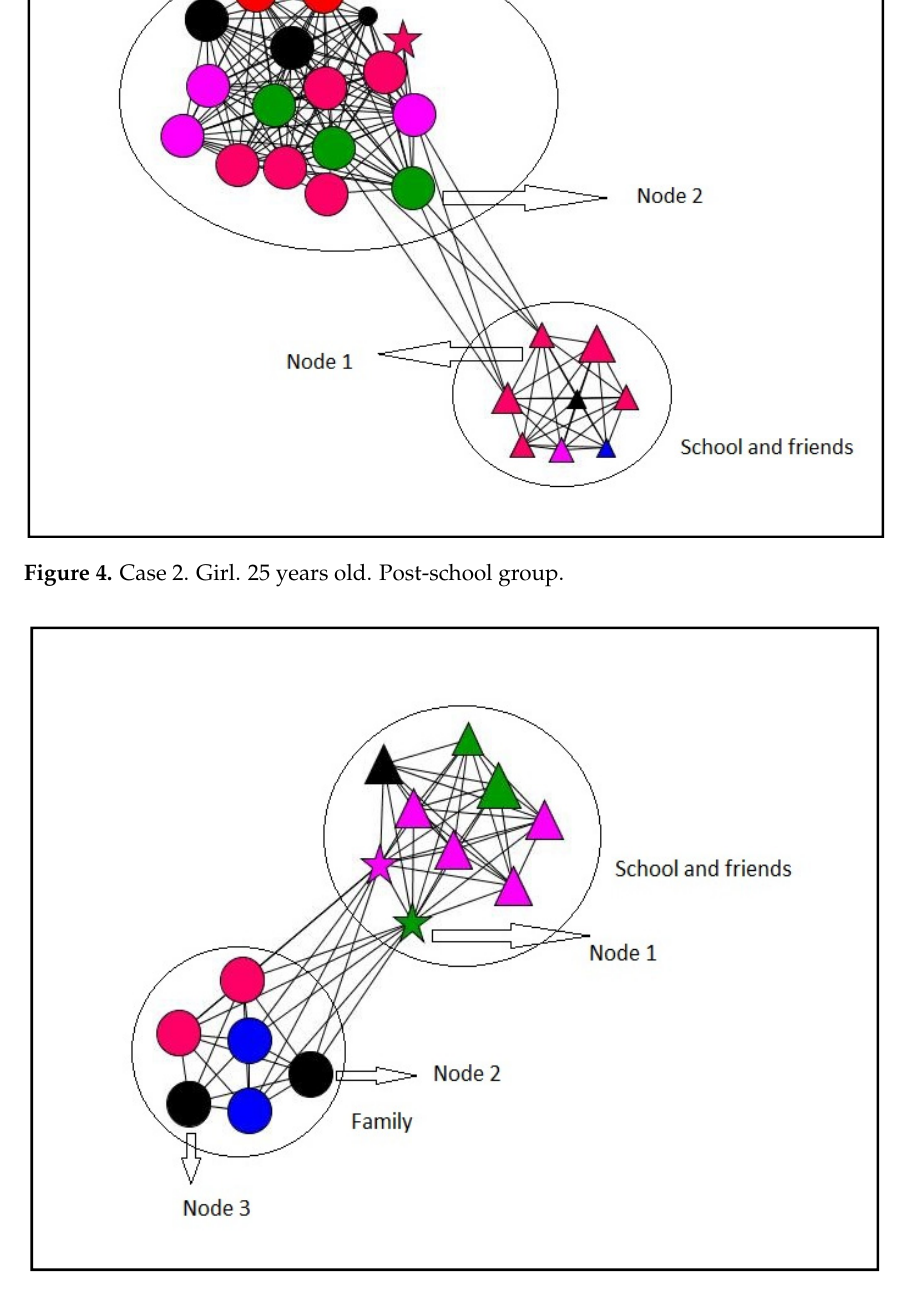
Figure 4. Case 2. Girl. 25 years old. Post-school group.